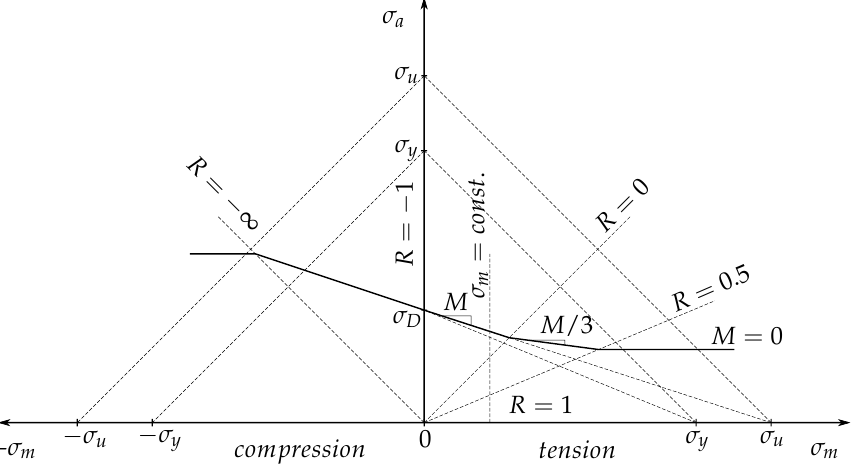
Figure 14. Haigh diagram. Adapted from